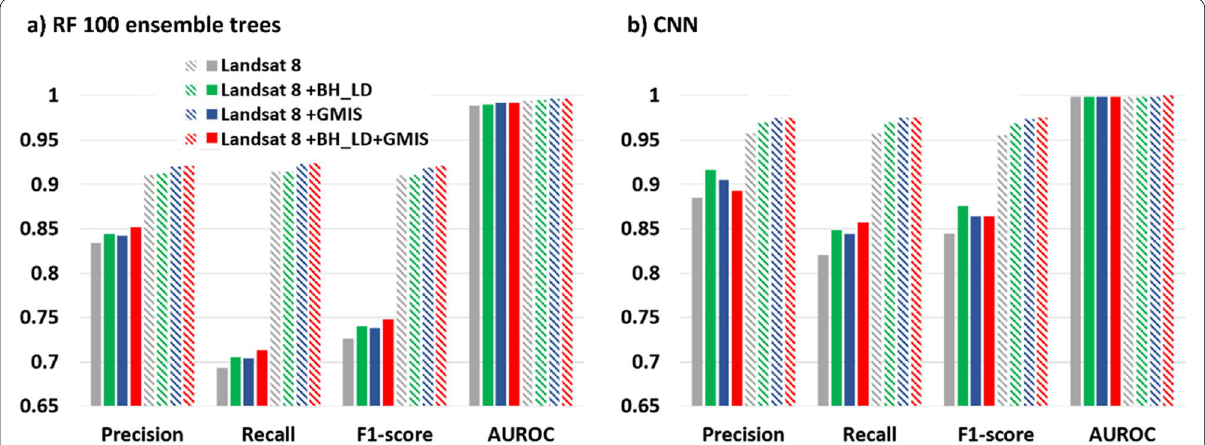
Fig. 6 The evaluation indices (macro‑ and micro‑average of precision, recall, F1‑score, and AUROC) for different input datasets using a RF100 and b CNN classifier. Solid (stripe) shading indicates the macro‑(micro‑) averaged indices